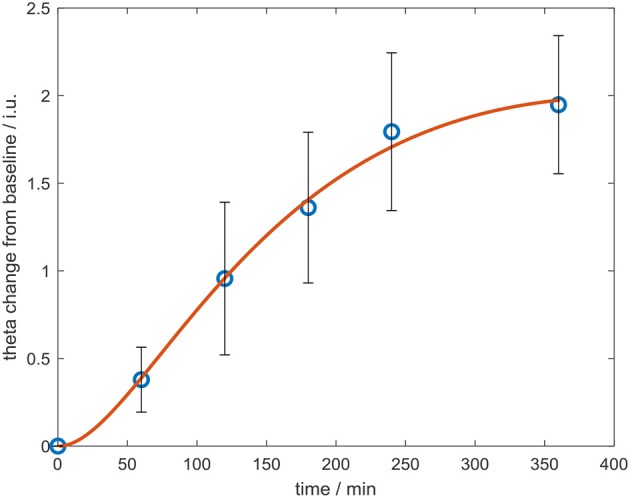
Change in whole-brain theta power from baseline over the course of the experiment, after the 60 mg dose of baclofen, with eyes shut. Data are mean ± S.E.M. The data were fitted using a compartmental model (red line).